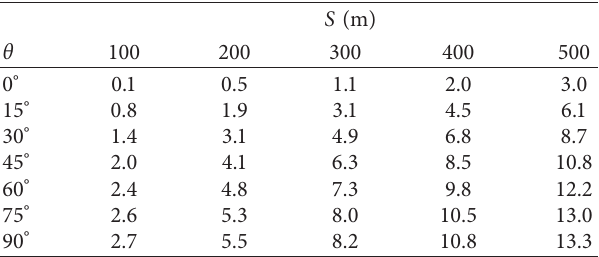
Table 5: c 2 as a percentage of the maximum velocity for the radial wall jet at location